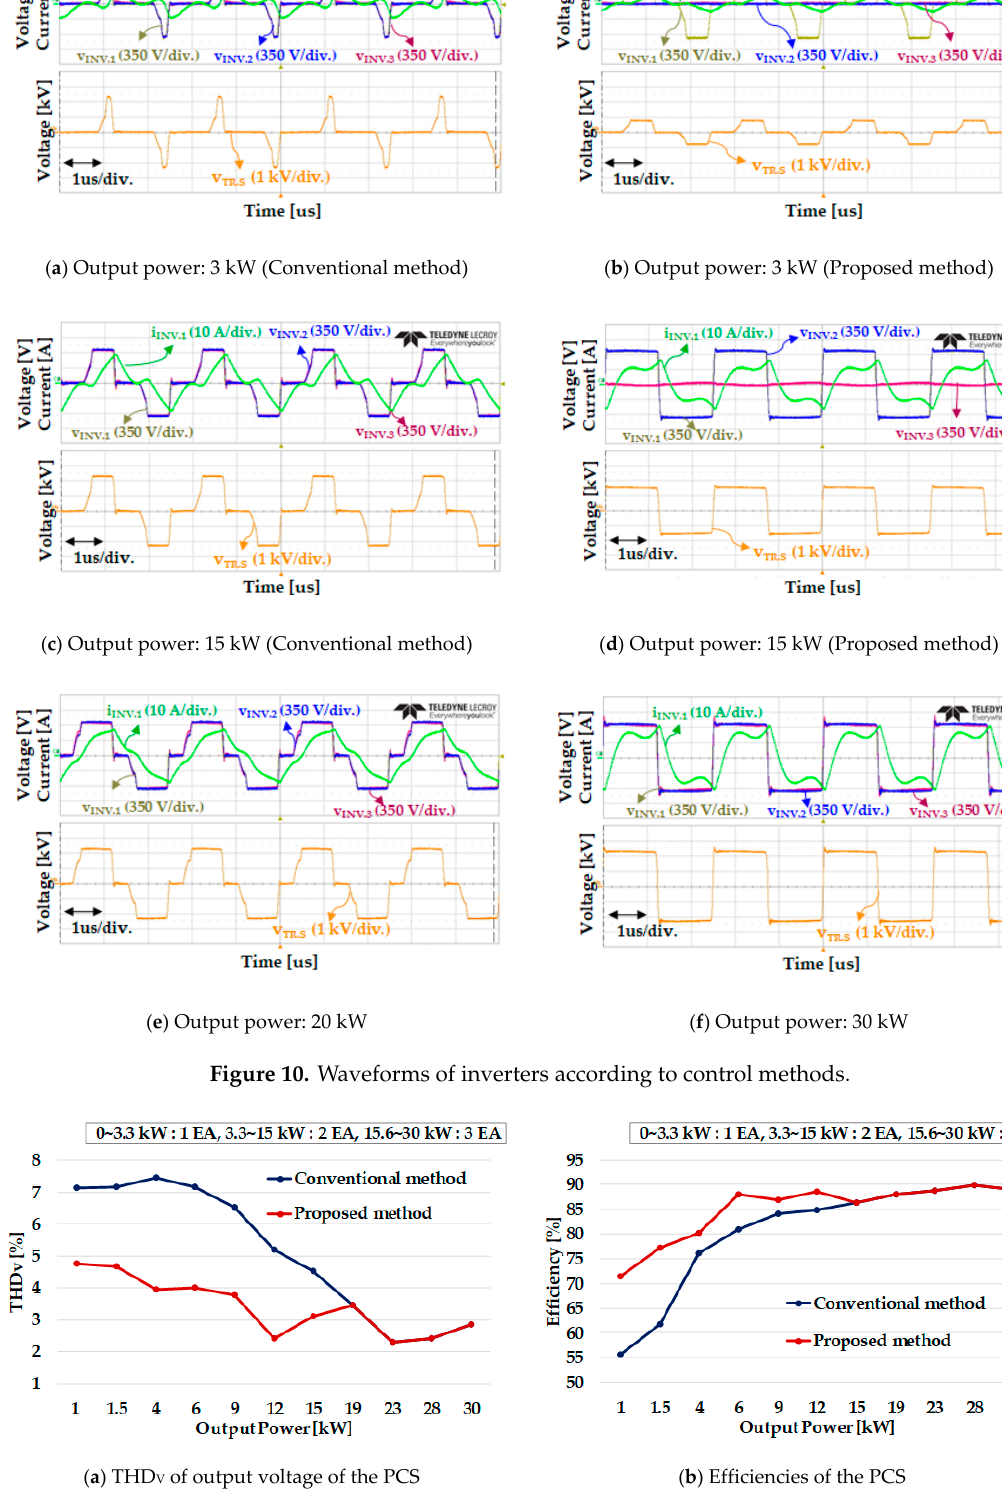
Figure 11. Experimental results of the PCS for the plasma generator.